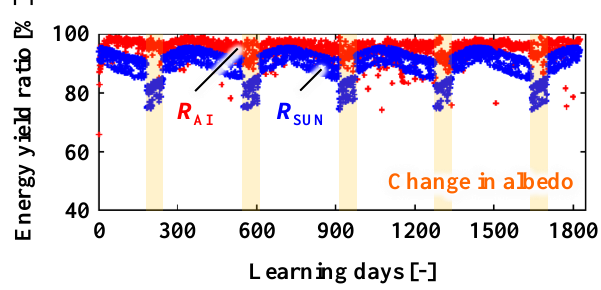
Figure 11. Variation of daily energy-yield ratio in the case of seasonal albedo changes (albedo = 0.8 from 1 July to 31 August, albedo = 0.5 for the other months, RUN 1).